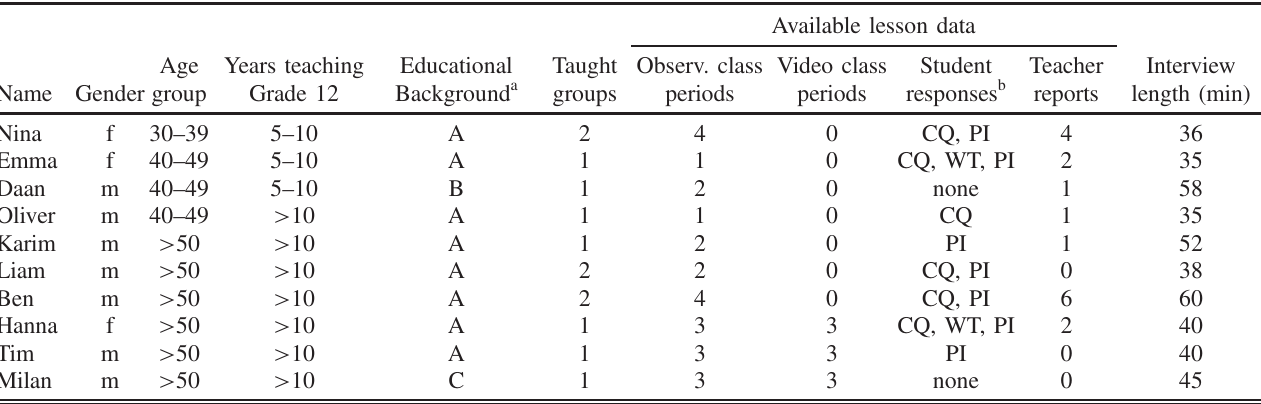
Available lesson